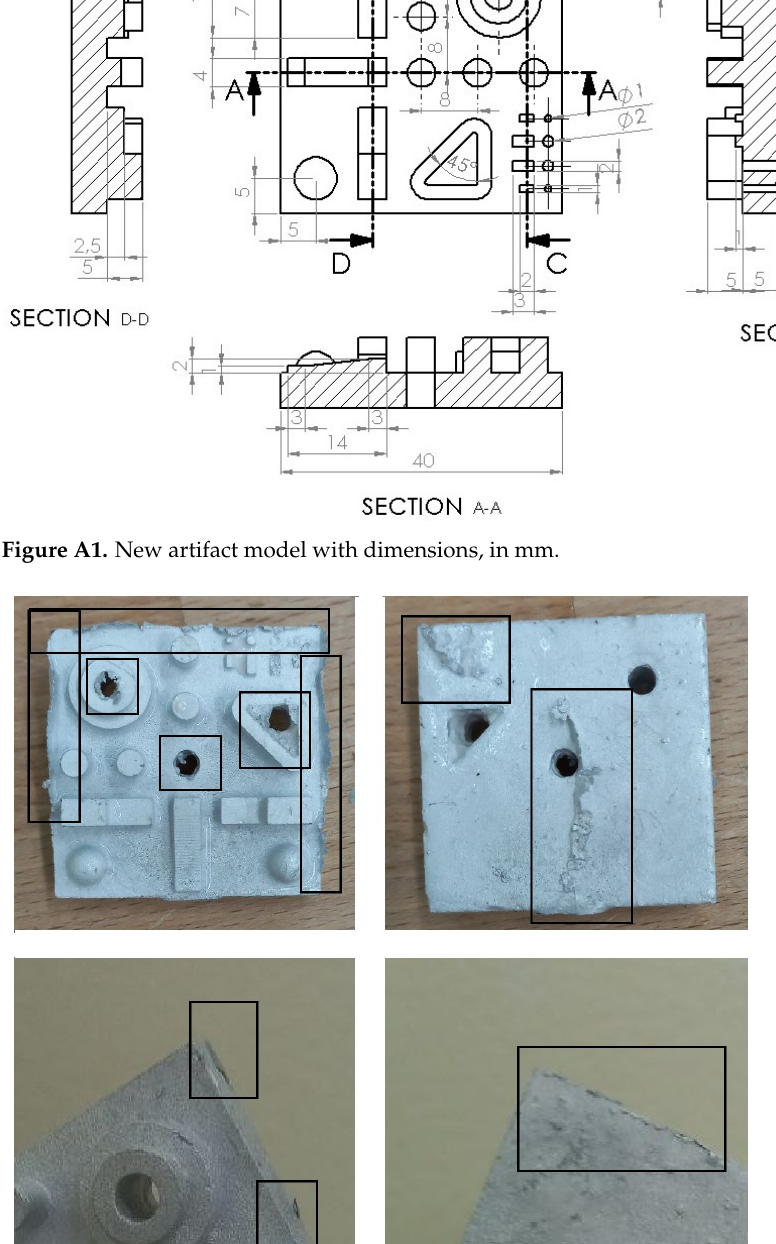
3 Table A2. Mean ranking of parameters for geometric characteristic of patterns. Characteristics